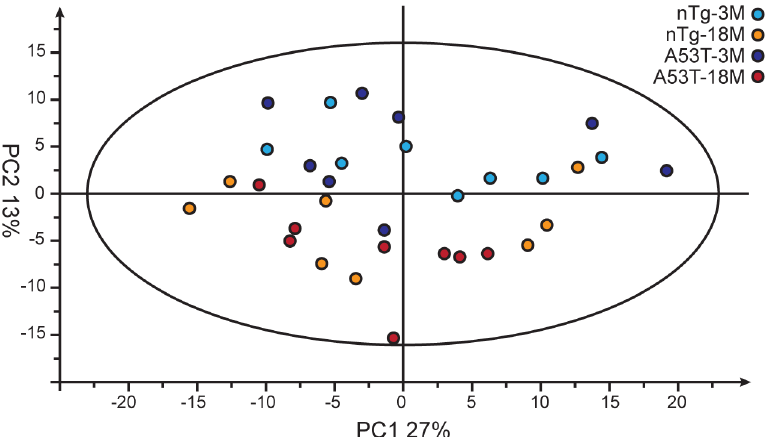
Fig 1. Principle component analysis (PCA) of brain metabolites influenced by aging and Parkinson ’ s disease-related α -synuclein A53T mutation. PCA plot showing a segregation of the metabolites affected in all the aged mouse brain samples (colored by dark and light red for A53T and nTg mice) from the young ones (colored by dark and light blue for A53T and nTg mice). The first principle component (PC1) accounts for 27% of the overall variability; the second principle component (PC2) accounts for 13% of the overall